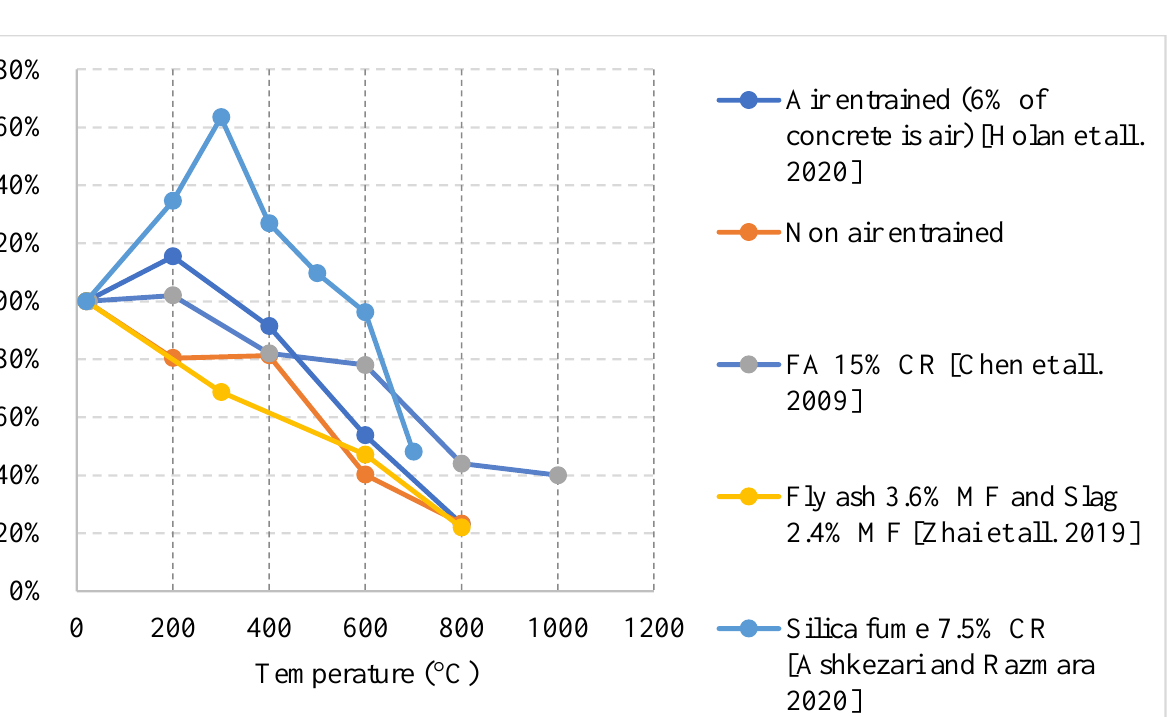
Figure 5. Effect of different constituents on the relative compressive strength of naturally cooled NSC [4,5,39,43,44].